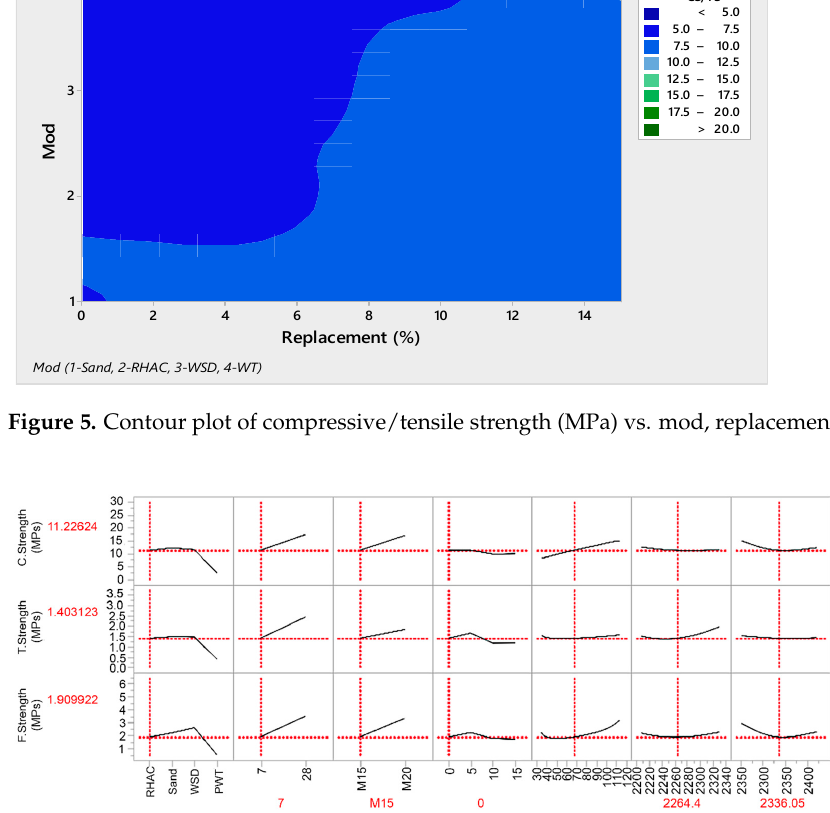
Figure 6. Prediction profile graph for the analysis of mechanical properties of green concrete. Coatings 2021 , 11 , x FOR PEER REVIEW